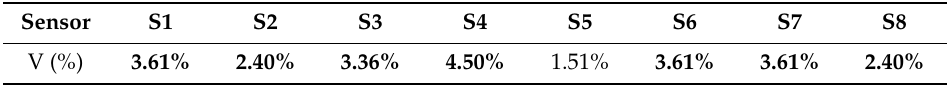
Table 18. The measured concentration volume fraction of deployment scheme based on WGABC algorithm.